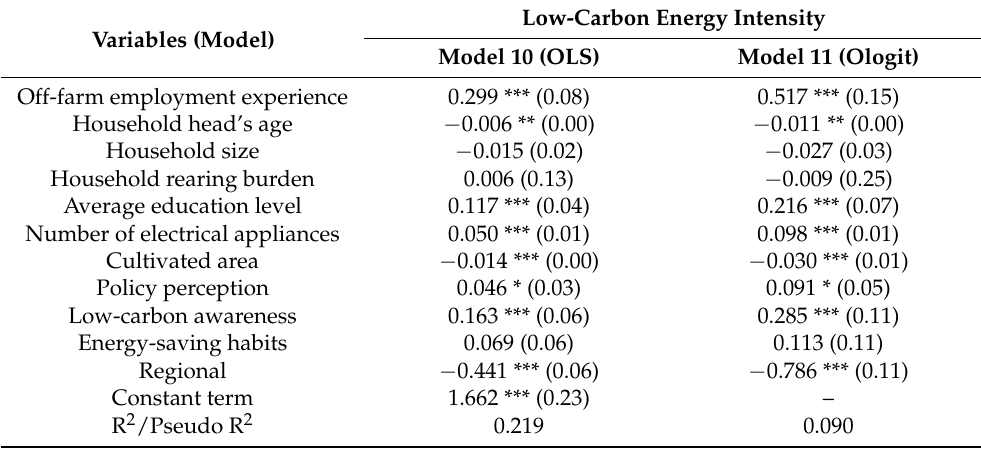
Table 6. Off-farm employment experience and farmers’ low-carbon energy intensity (N = 1351).